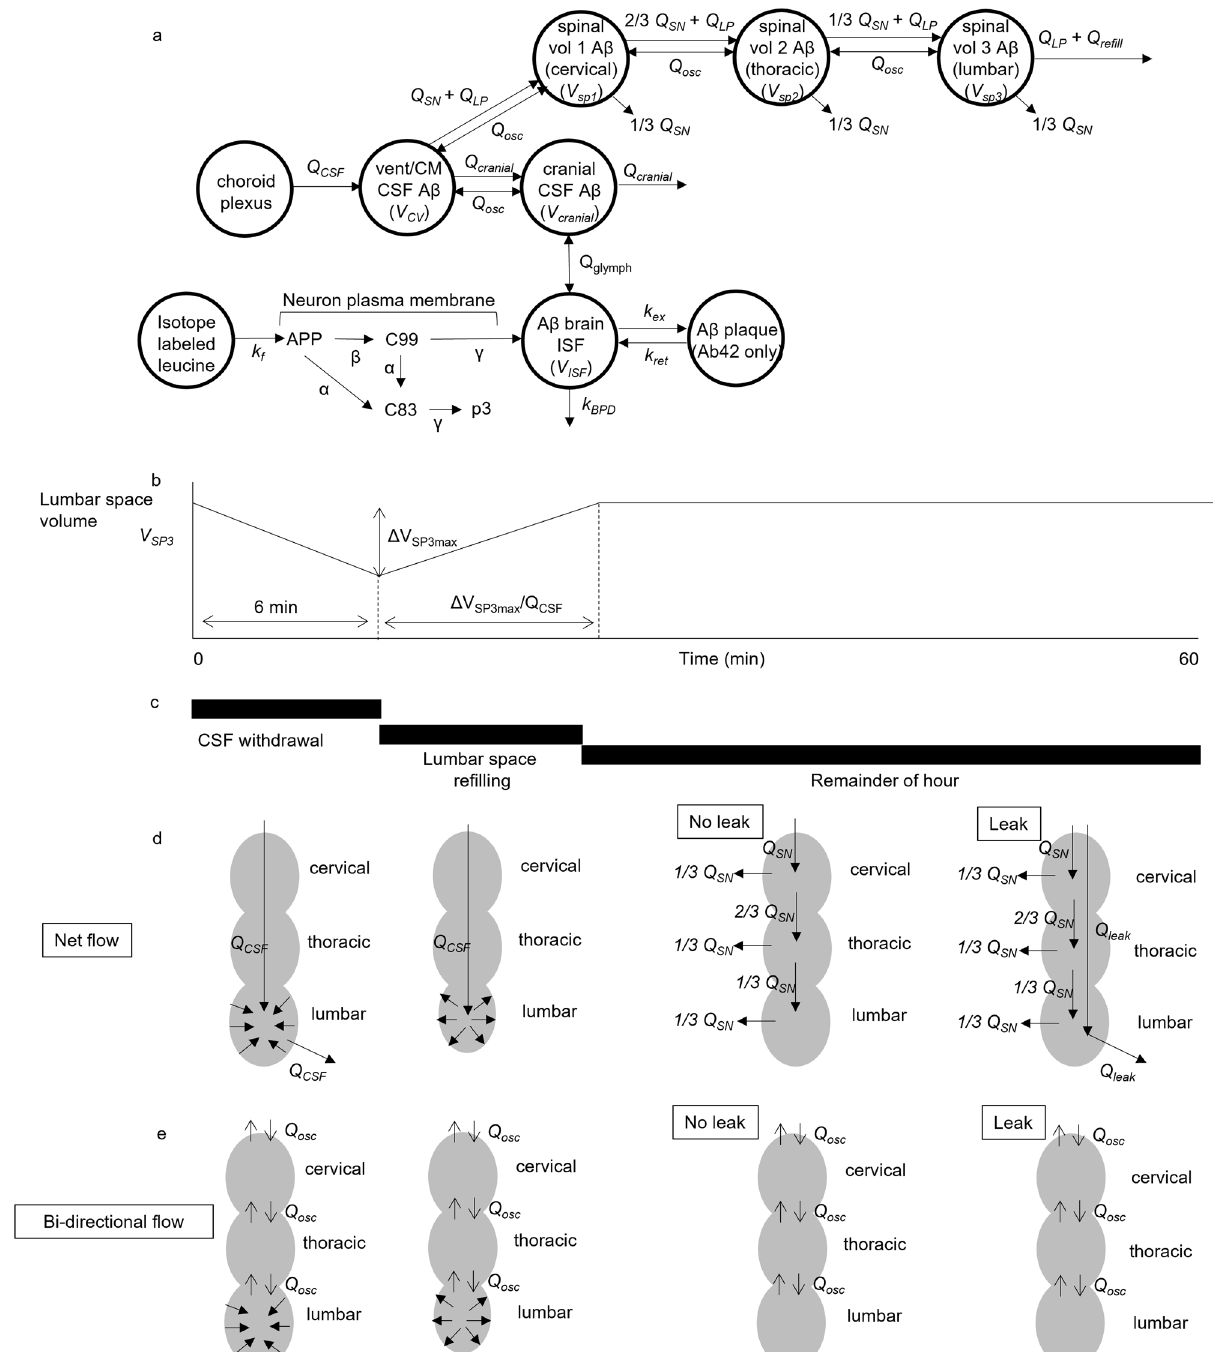
Fig. 1 Model of A β production, transport, and clearance. Physiological model of CNS during SILK study, incorporating fl uid fl ows, ISF and CSF compartment volumes, and Michaelis – Menten kinetics for A β production. a Model structure. b Flows in the spinal SAS due to hourly CSF withdrawal. The volume of the lumbar SAS decreases when the CSF withdrawal rate Q LP exceeds the CSF production rate (Q CSF ) and subsequently re fi lls with CSF to its original volume. c Timeline of hourly CSF withdrawal. d Net fl ow in the spinal SAS. e Bidirectional fl ow in the spinal